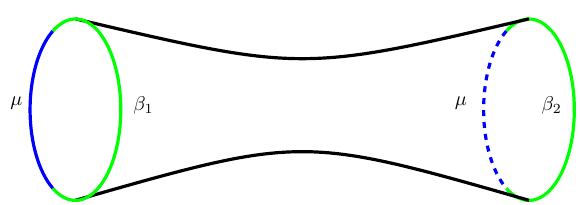
Figure 4 . Two trumpet geometries glued together along their closed geodesic boundaries. This geometry corresponds to the connected part of the spectral form